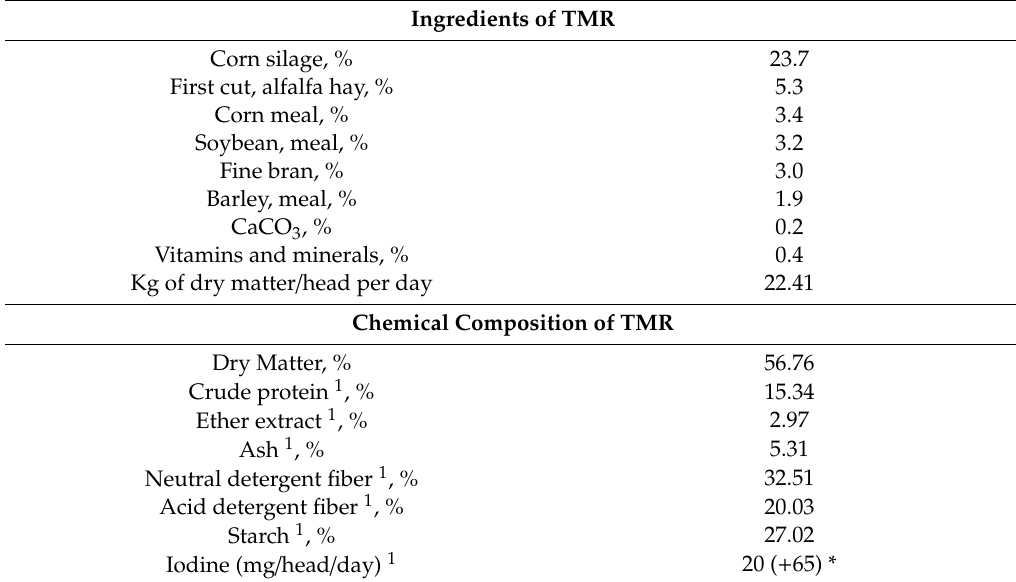
Table 1. Ingredients and composition of total mixed ration (TMR) administered to each animal of both group of